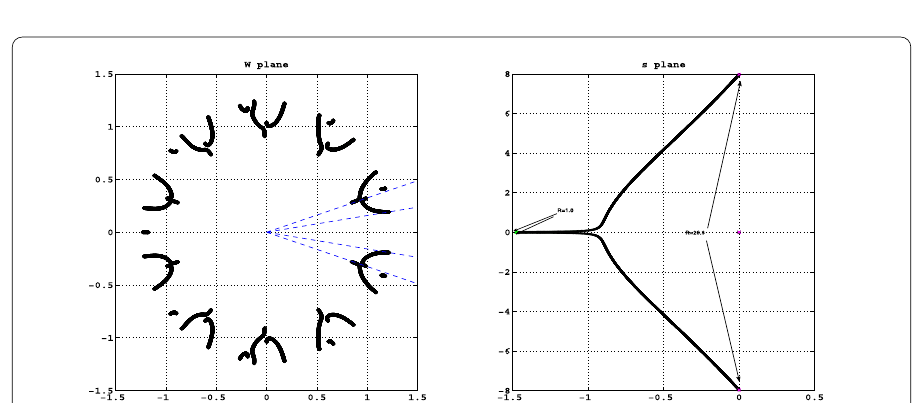
Figure 5 Poles in W -plane and s -plane G = 3 and fractional orders α 1 = 0.99 and α 2 = α 3 = 1.